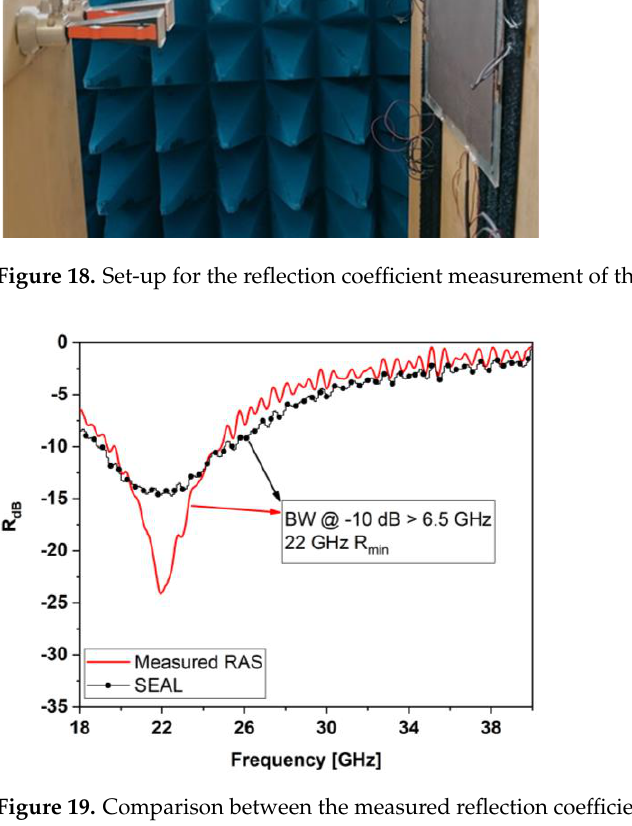
( d ) Figure 20. ( a ) Schematic representation of the surface subdivision map. Conductivity maps of the piezoresistive strips at the maximum induced plate deformation of the sensors as a function of the load applied on the zones: P1 ( b ), P4 ( c ), and P5 ( d ). Table 2. Simulated resistance variation of the four sensors, depending on the force application point. Point